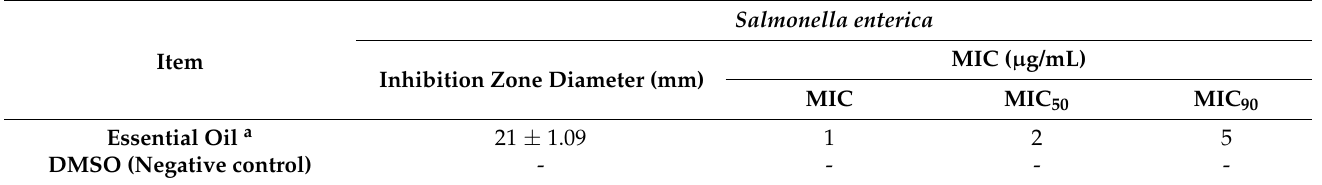
Table 1. Inhibition zone diameter and MIC of S. officinalis L. EO against S. enterica .